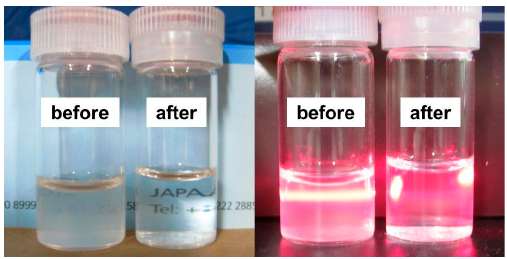
Figure 3. Photographs of EI 4 /Gal-Dex- g -SS-OLA nanogel before and after 24 h incubation in the presence of 10 mM dithiothreitol (DTT) in PB solution at 25 °C with ( right ) and without ( left ) laser beam irradiation.